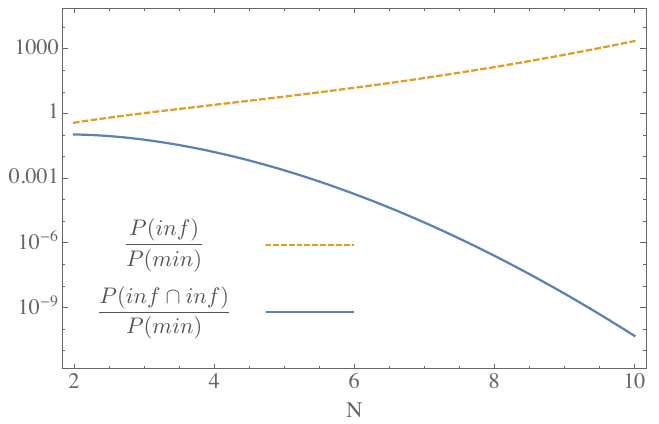
Figure 6 . The number of in(cid:13)ationary regions per minimum with (blue/continuous line) and without (yellow/dashed line) conditioning on a graceful exit, averaged over all